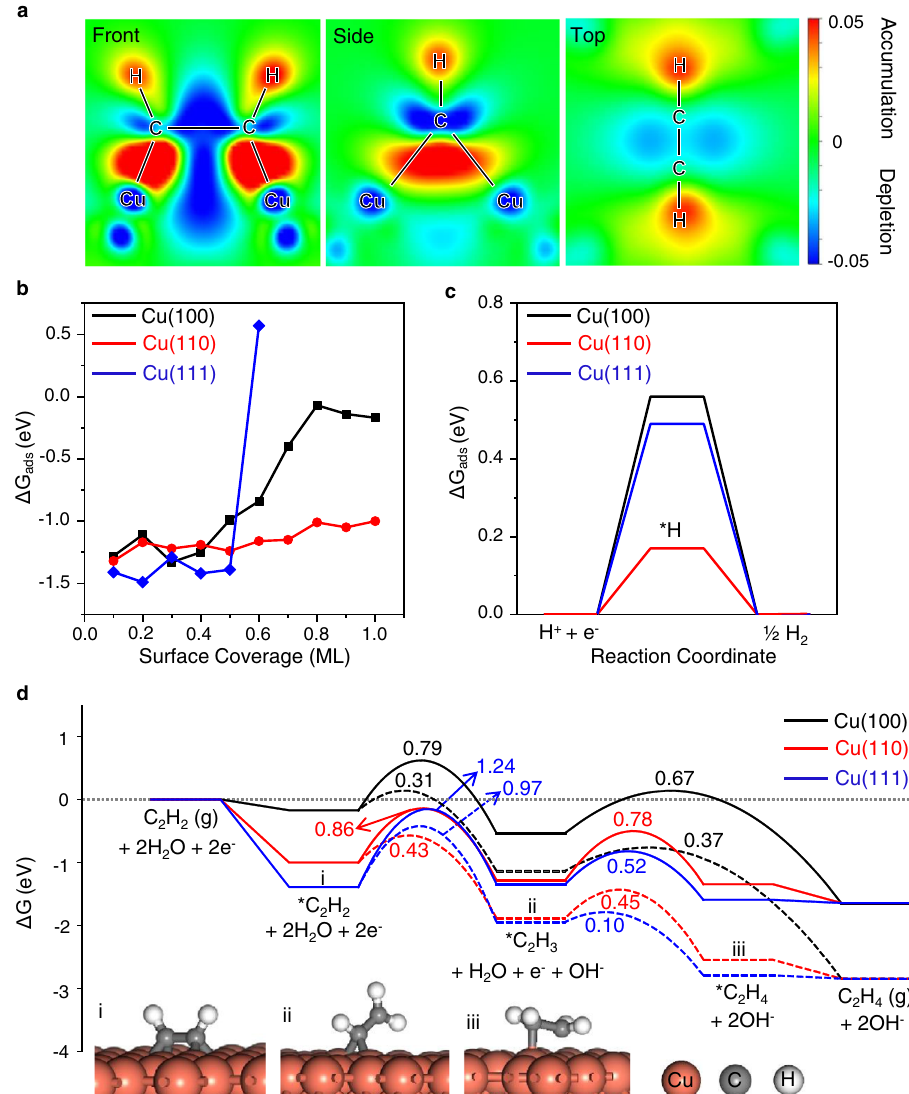
Fig. 4 Theoretical insight into the reaction mechanism. a Charge density difference of the adsorbed C 2 H 2 on the Cu surface at front, side and top views. Charge accumulation and depletion regions are shown in red and blue respectively. b Adsorption free energy of C 2 H 2 on Cu(100), (110), and (111) surfaces at different coverages at 25 °C. c The free energy pro fi le diagram of hydrogen evolution reaction at 0 V vs. RHE, 25 °C on the covered Cu surfaces. d Free energy diagram for the formation of C 2 H 4 on Cu(100), Cu(110), and Cu(111) covered surfaces at 0 and − 0.6 V vs. RHE, 25 °C. The solid lines represent the potential energy surfaces at 0 V, while the dashed lines represent the potential energy surfaces at − 0.6 V. For a clearer description of the reaction states only the species concerned are shown in the inserted screenshots, the neighboring adsorbed species are not shown for simplicity. Source data are provided as a Source Data fi This also indicates that the * C 2 H 2 is not likely hydrogenated by surface * H, but rather via electron-coupled proton transfer from the water layer (Eq. 1), as also re fl ected by the pH effect on the overall Faradaic ef fi ciencies for acetylene hydrogenation and HER, where a lower pH is more favorable for the hydrogenation of acetylene than the HER (Supplementary Fig. 23).